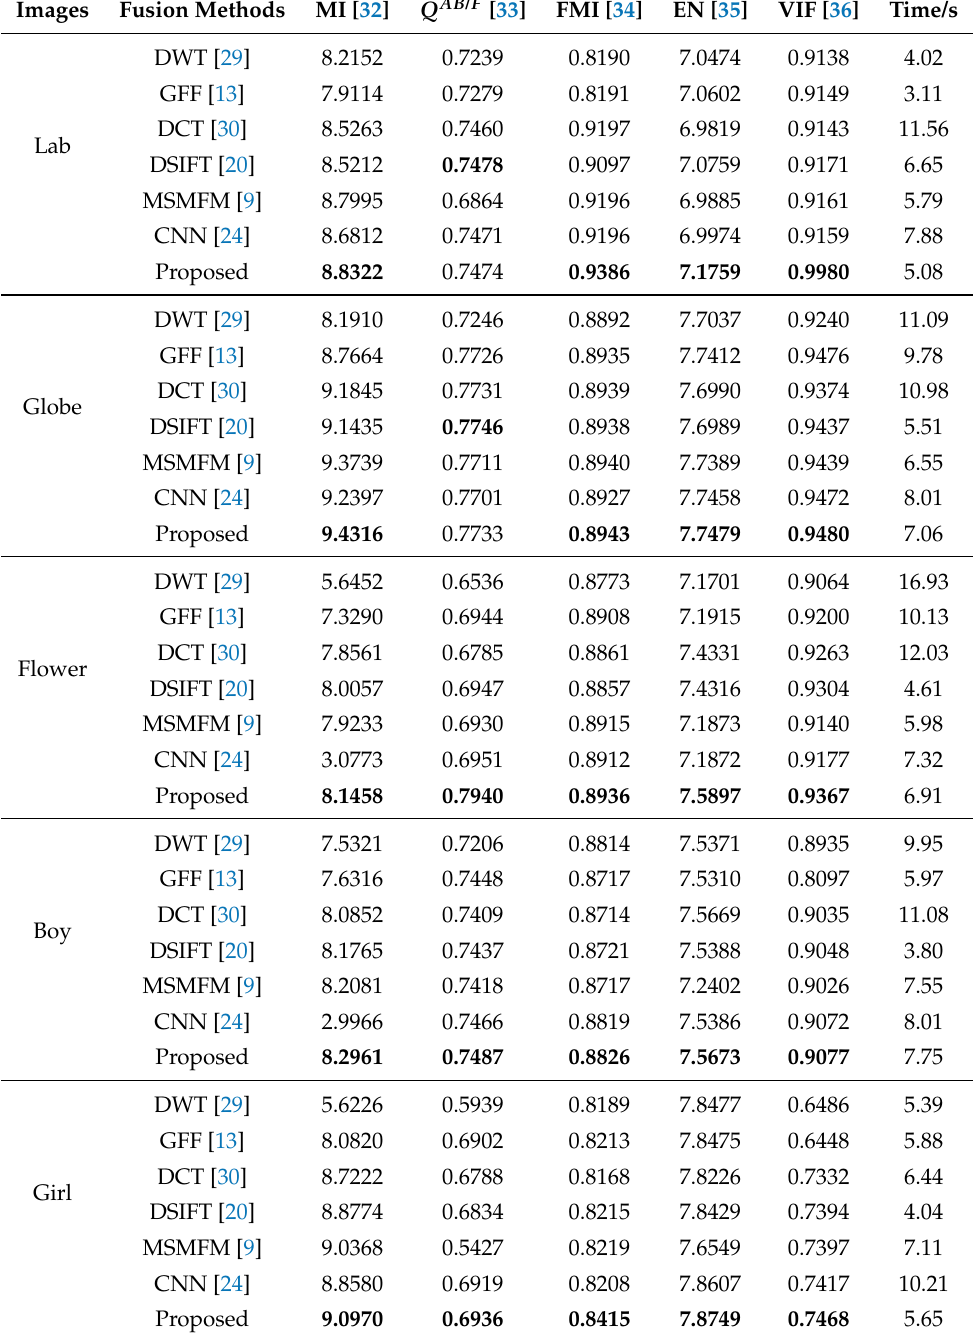
Table 1. The quantitative assessment of different fusion